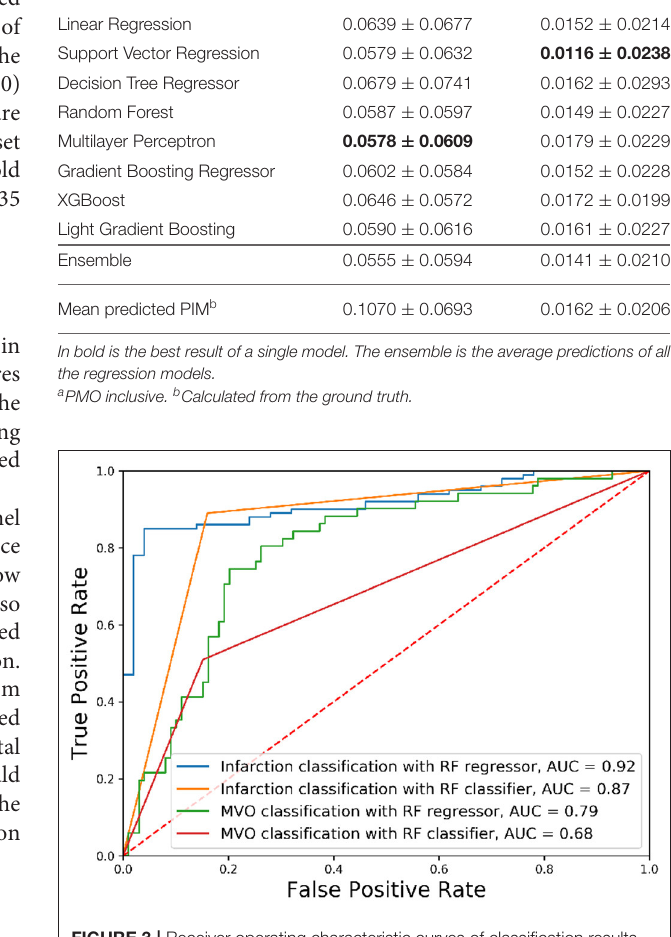
FIGURE 3 | Receiver operating characteristic curves of classification results. The classification of different tissues was realized with Random Forest (RF) algorithms with different optimization